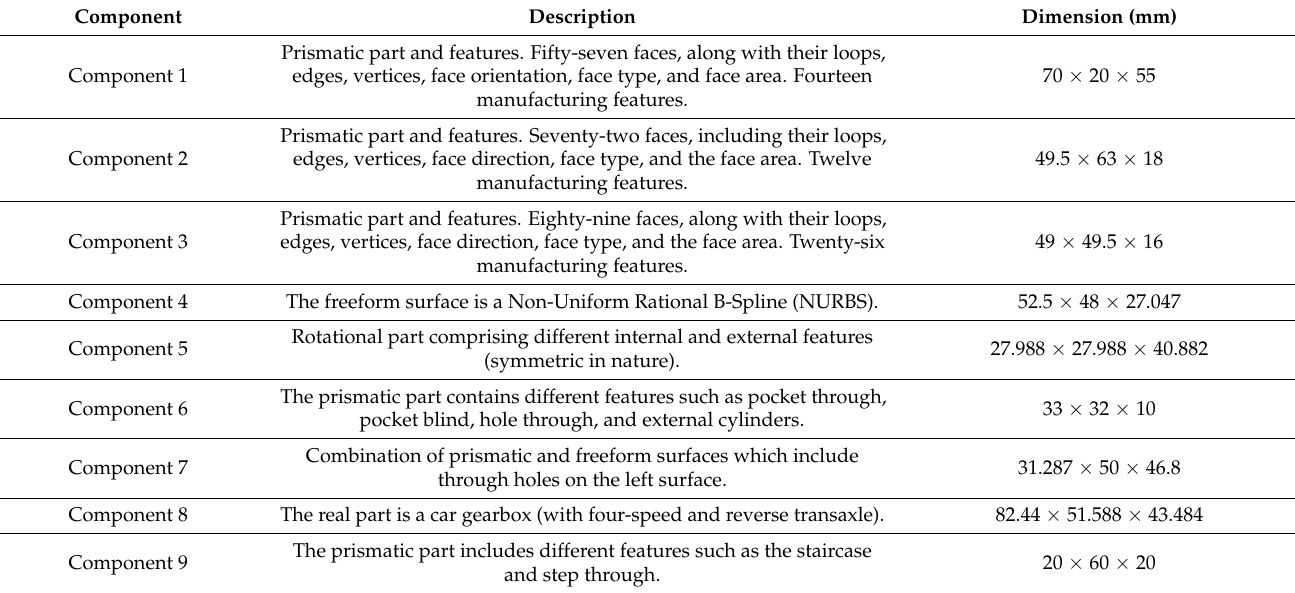
Table 4. Details of nine selected components.